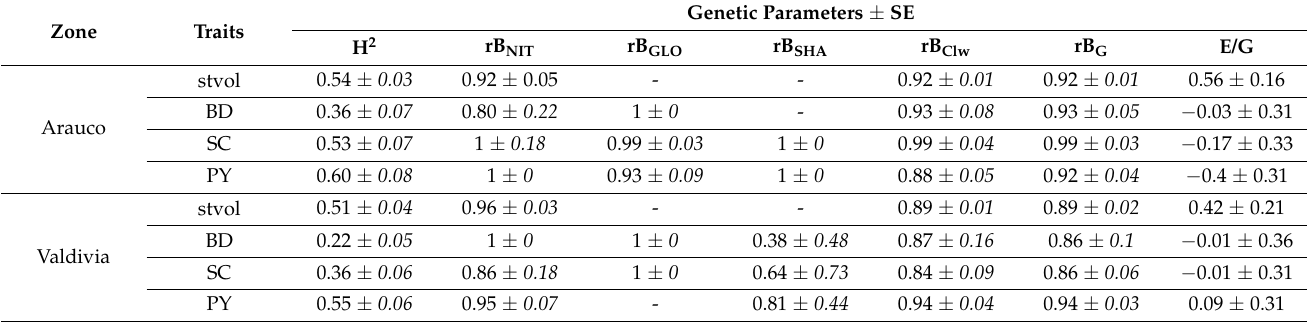
Table 4. Genetic parameter estimates from combined-site analysis for standardized volume (stVol), Basic Density (BD), Specific Consumption (SC), and Pulp Yield (PY) in Arauco and Valdivia zone with their respective SE. H 2 is the broad-sense heritability. rB NIT , rB GLO , rB SHA , rB Clw, and rB G are the type-B genetic correlations for GHA NIT , GHA GLO , SHA, Clw, and G x site interaction, respectively. E/G is the epistasis ratio between epistasis and total genetic